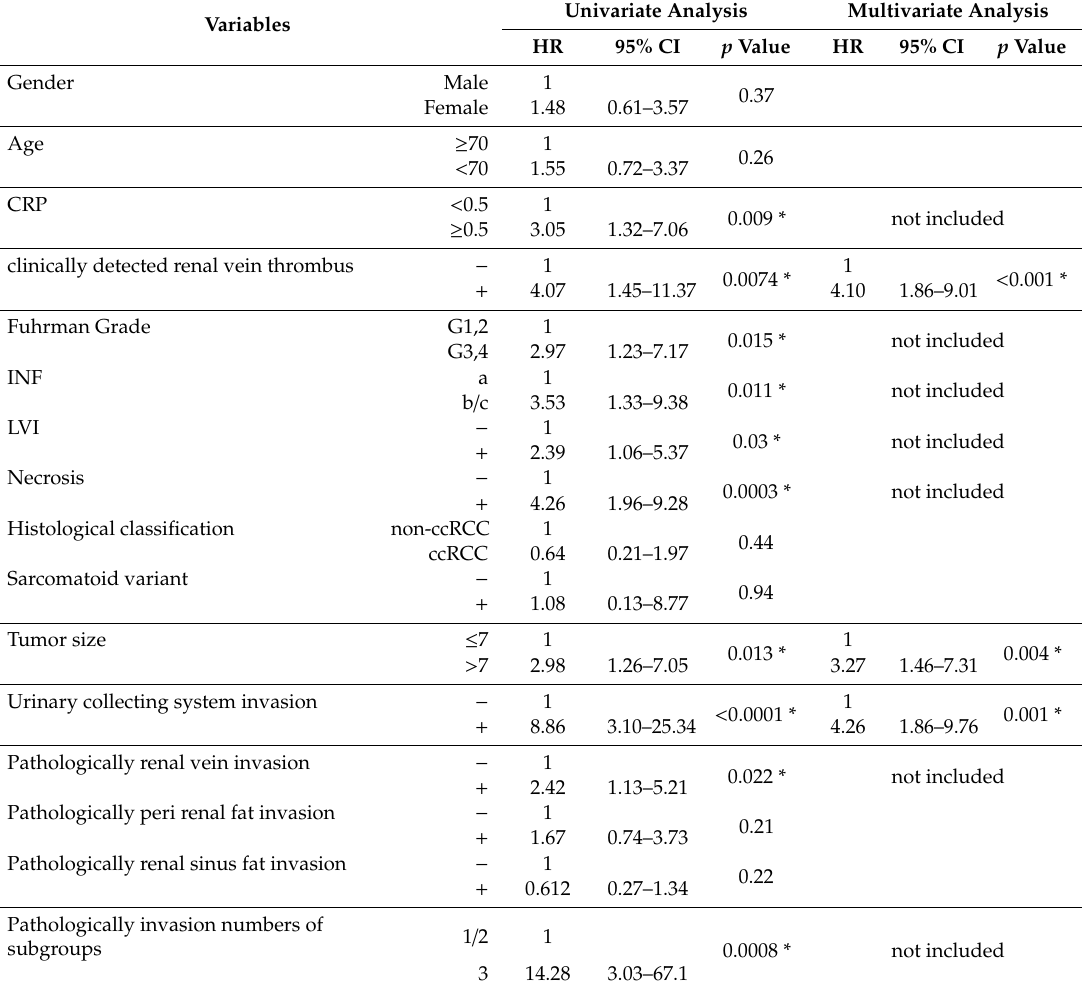
Table 2. Univariate and multivariate cox regression analyses for RFS (* statistically